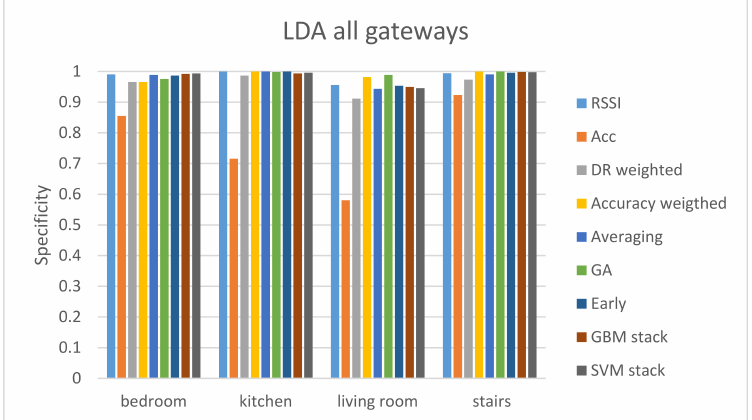
Figure 7. Specificity results of the LDA classifier for the evaluation protocol